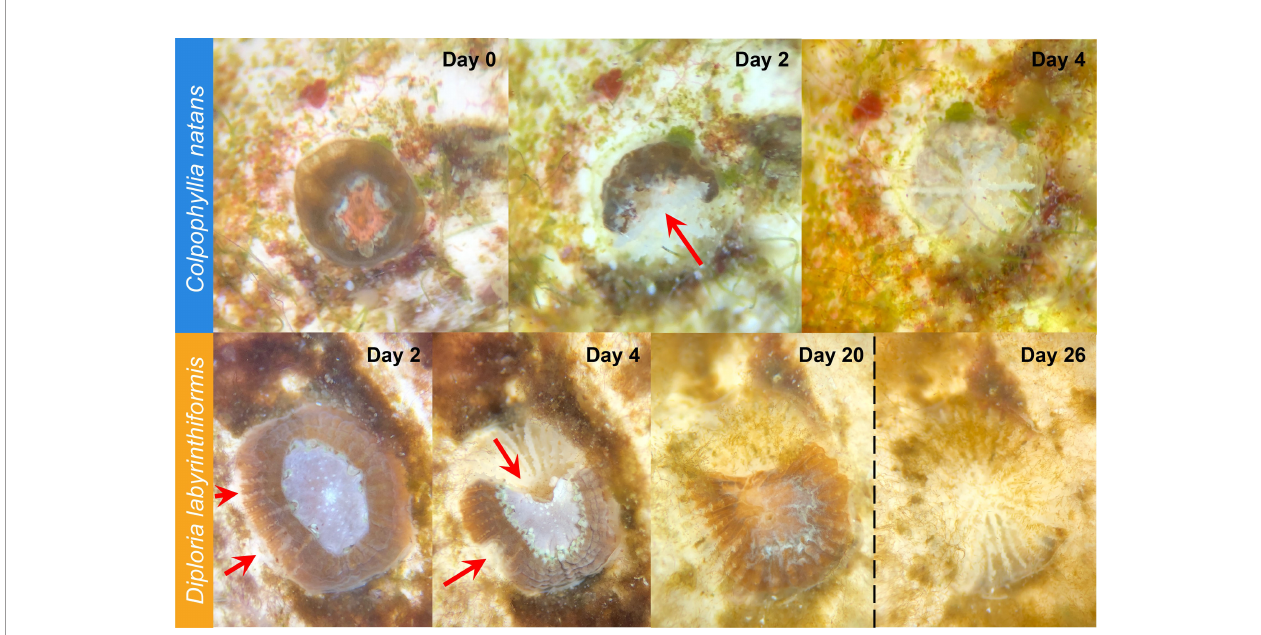
FIGURE 3 | SCTLD progression in brain coral recruits. Top: C. natans recruit showing progression from apparently healthy to 100% tissue loss within four days (~25% tissue loss per day). Red arrow indicates active disease margins. Bottom: D. labyrinthiformis recruit showing progression from apparently healthy to ~50% tissue loss over four days, then halting lesion progression with no further major tissue loss until Exposure 2 (dashed vertical line). Red arrows indicate active disease margins.